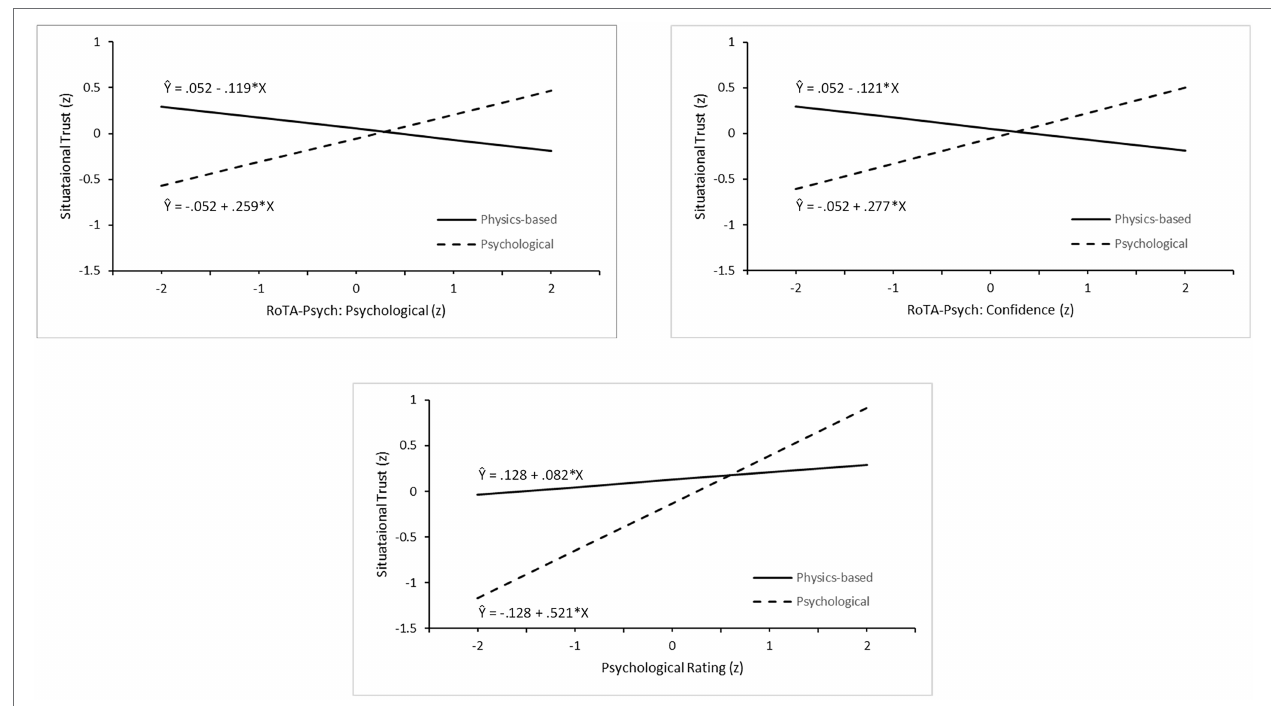
FIGURE 4 | Regression plots for three interactive effects of robot analysis type and individual difference factors: Robot Threat Assessment (RoTA)-Psych psychological judgment scale (upper left), RoTA-Psych confidence scale (upper right), and scenario rating of robot psychological judgment (lower